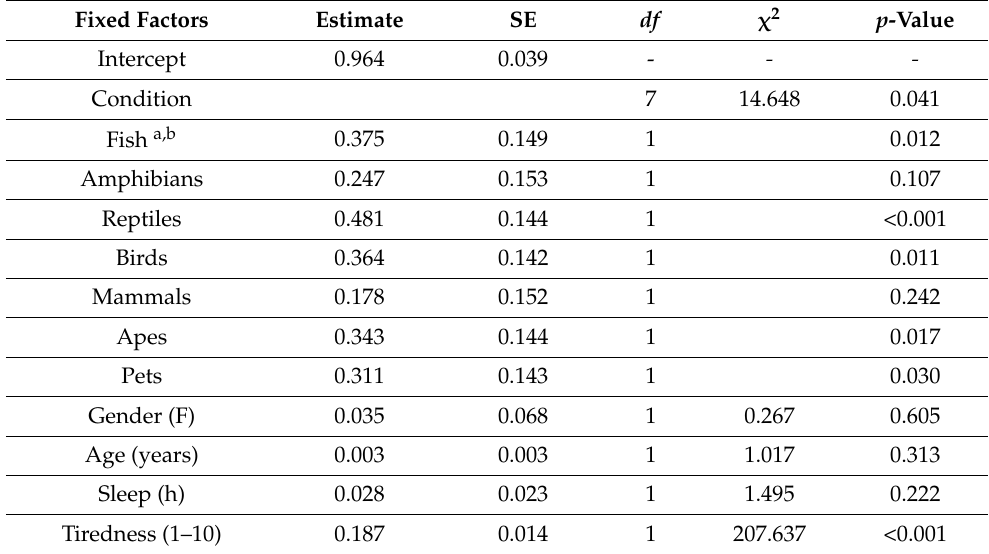
Table 3. Estimated parameters (Estimate), Standard Error (SE), and results of the likelihood ratio tests ( χ 2 ) for the Poisson distribution.